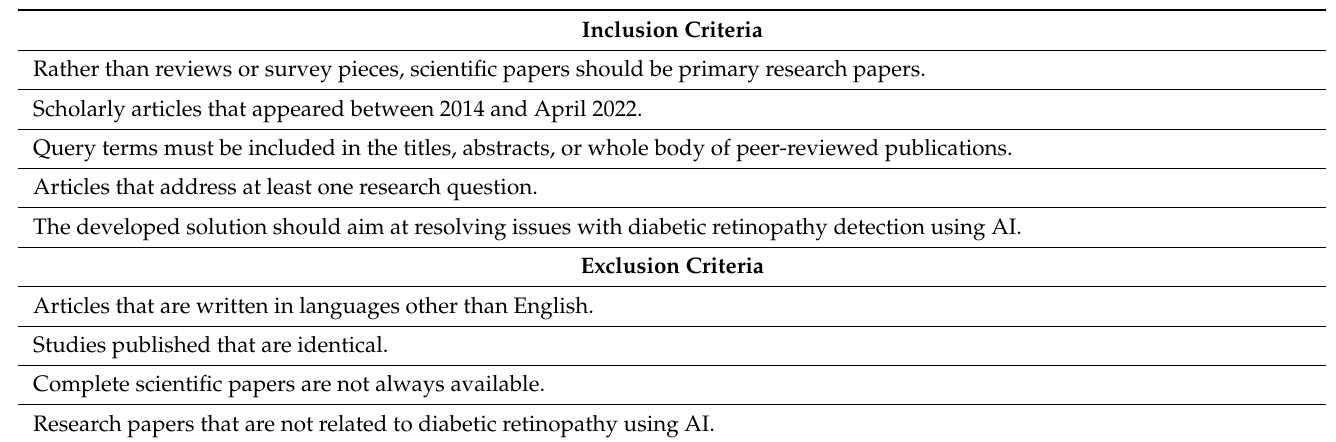
Table 5. Inclusion and exclusion criteria